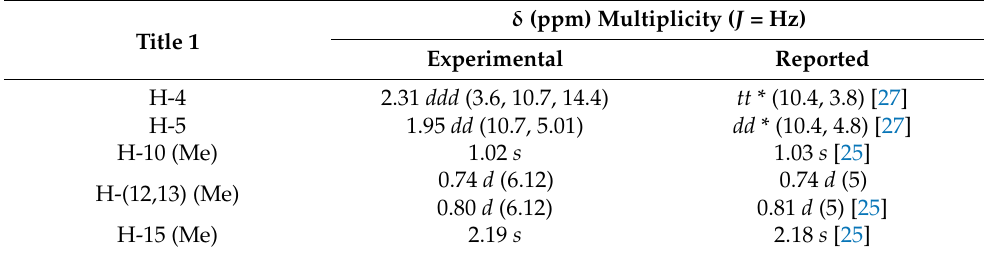
Table 3. Summary of identified protons in the 1 H spectrum of faurinone.